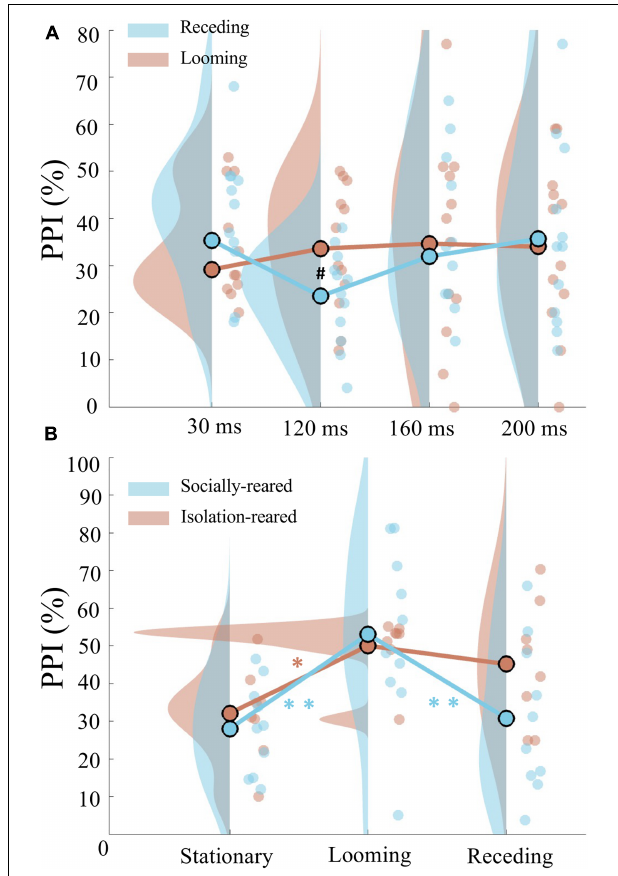
FIGURE 2 | Prepulse duration and rearing type on looming-induced attentional modulation of PPI. (A) Raincloud plots of PPI induced by looming prepulse (red) and receding prepulse (blue) when the prepulse duration was 30, 120, 160, and 200 ms. Note that a marginal significant difference of PPI between the looming and receding prepulses was observed when both the prepulses were 120 ms. (B) Different modulated PPI by two rearing types. Not that in socially reared rats (blue), PPI was significantly increased by looming prepulse than PPI induced by stationary and receding prepulse; in isolation-reared rats (red), PPI was only increased by looming prepulse than PPI induced by stationary prepulse. No difference of PPI between looming and receding prepulses was found. Circles are individual data; circles with black edge color show the average of group data; distributions show probability density function of data points. ∗ Indicates p < 0.05, ∗∗ indicates p < 0.01, and # indicates p <